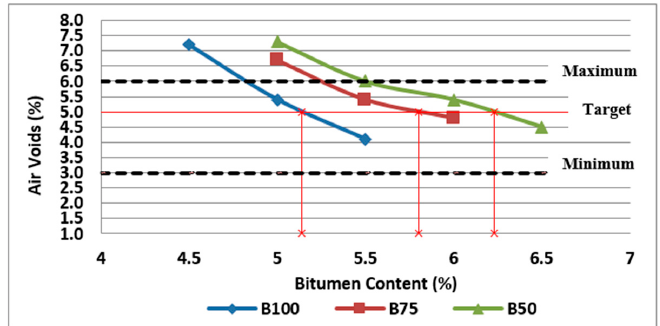
Figure 4. Effect of bitumen content and RCA content on air voids of Mix I containing virgin aggregate and Mix II and Mix III containing RCA as coarse aggregate.